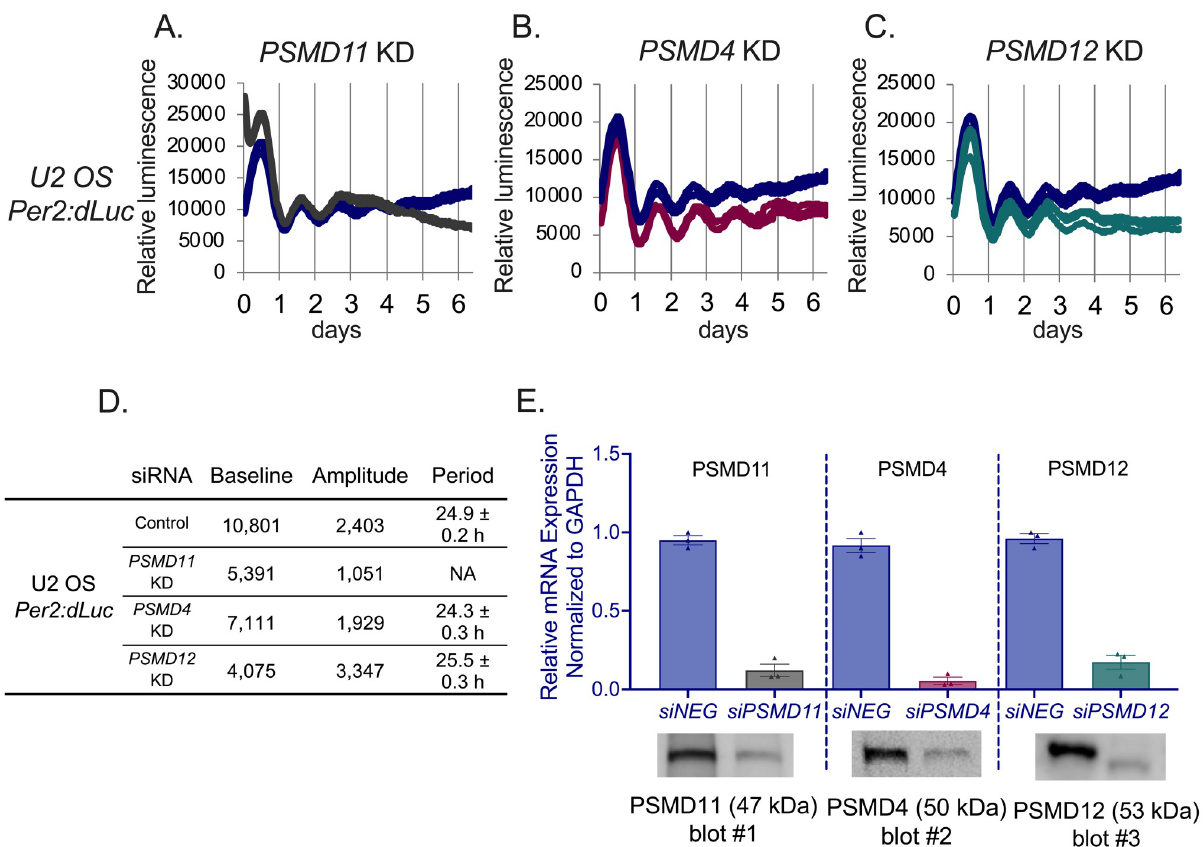
Fig 1. PSMD11 regulates cellular circadian clocks, but PSMD4 and PSMD12 do not. (A), (B), (C) PSMD11, PSMD4 and PSMD12 knockdown cellular circadian profiles. Representative bioluminescence records of circadian rhythms in U2 OS Per2 : dLuc reporter cells. n = 3 independent experiments (D) Baseline, amplitude and phase results of A-C that are calculated with WaveClock algorithm. (E) mRNA levels detected with QPCR to check the RNAi knockdown effects. mRNA levels are normalized to GAPDH. Statistical analyses were performed with unpaired t tests. Error bars represent SEM. Representative Western blot images to confirm the protein level effect is shown below for each gene. Stain-free loading controls are shown in S1B Fig. Uncropped controls and images for each Western blot image are represented in ‘S1 Raw images’.